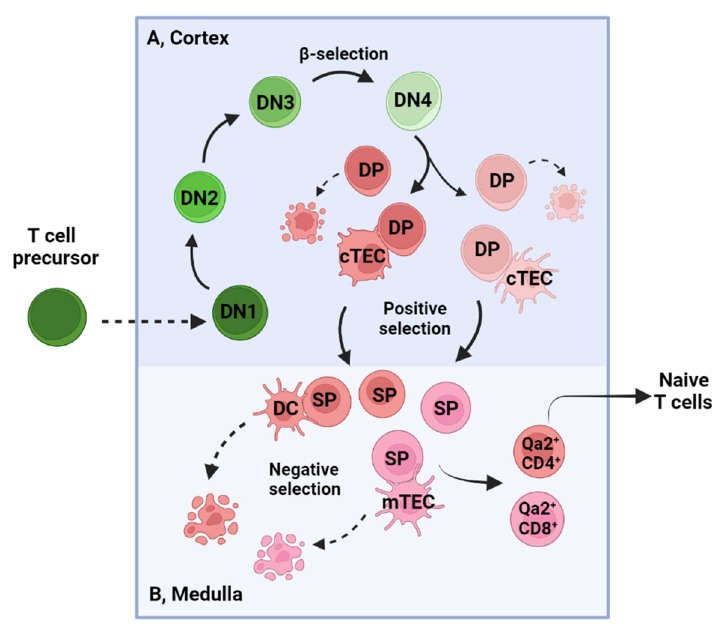
Figure 1. T cell development in the thymus. ( A ) T cell development in the thymic cortex. DN cells (green) undergo four stages from DN1 to DN4 based on CD44 and CD25 expression in the thymic cortex. DN1 cells (CD44 + CD25 − ) have multiple lineage potencies, but expression of the transcription factor Bcl11b in DN2 cells (CD44 + CD25 + ) commits them into T-cell lineages ( αβ and γδ T cells). The E2A/Notch1 signal transcriptionally controls the pre-T cell receptor (TCR) α expression, and the Myb/Gata3 signal is critical for TCR β expression. Pre-TCR complex at the DN3 stage (CD44 − CD25 + ) is formed due to the rearrangement of functional TCR β and pre-TCR α chains, which is critical for the further expansion and development of αβ T cells. This event is known as β -selection. After passing through β -selection, DN4 (CD44 − CD25 − ) cells begin to express the TCR α gene, CD4 and CD8, and step into the CD4 + CD8 + DP (red) stage. As the major population in the thymus, DP thymocytes complete TCR α gene rearrangement and form functional TCR αβ , which can